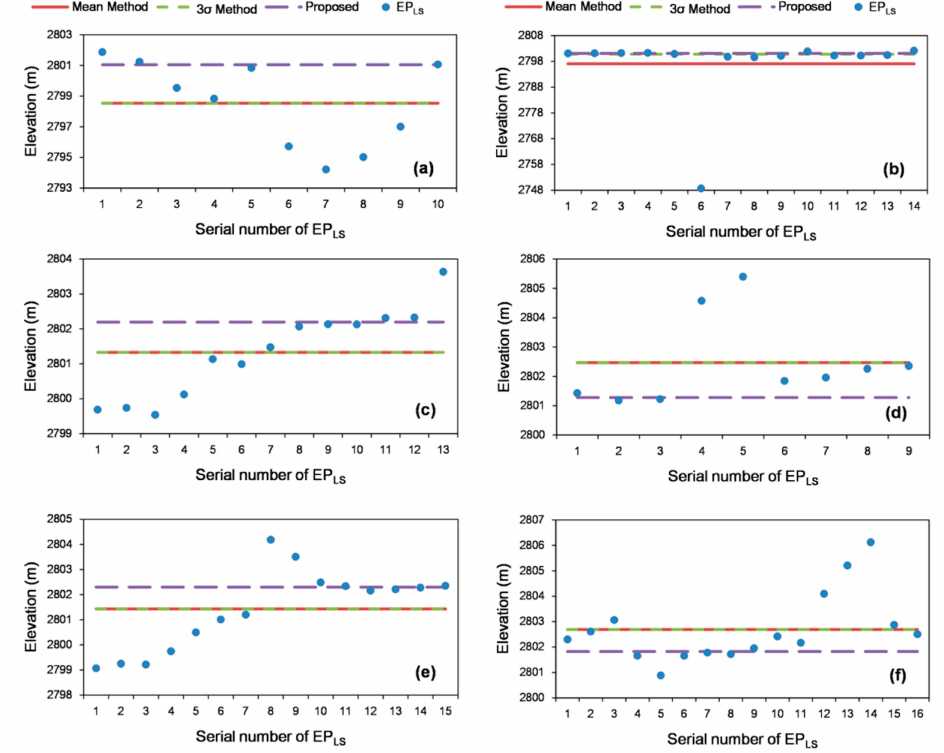
Figure 17. Results extracted by the proposed algorithm and the two other algorithms on ( a ) 29 May 2017, ( b ) 27 May 2018, ( c ) 28 April 2019, ( d )10 September 2019, ( e ) 30 November 2019, and ( f ) 19 October 2020. The red and green dashed lines denote the results extracted by the mean method and by the 3 σ method,